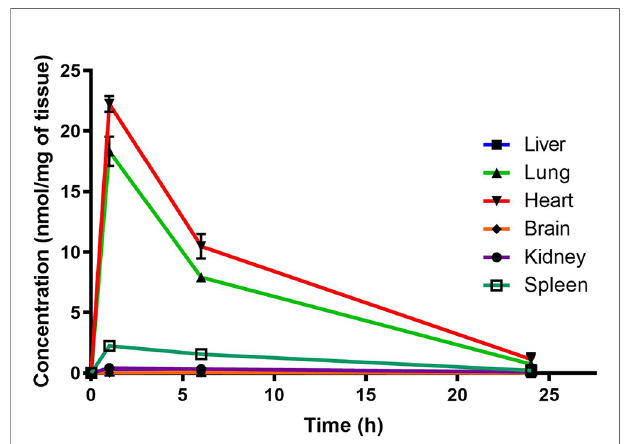
FIGURE 2 | Total PhX1 concentrations in murine organs (oral dose, 10 mg/ kg) (n = 3 per time-point; data presented as means ± SD).